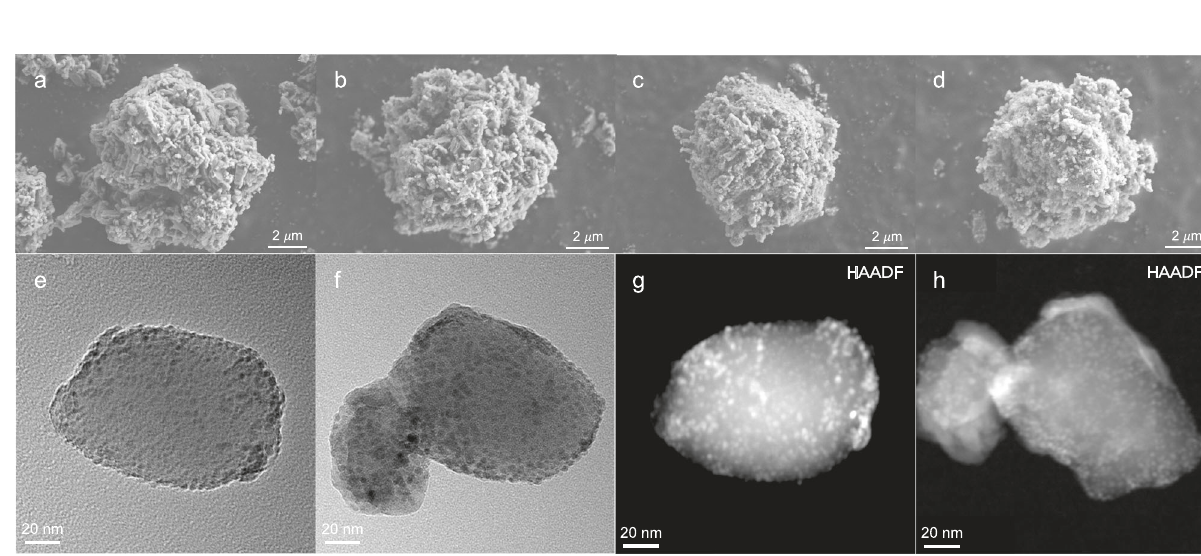
ZSM-5_H. TEM bright- fi eld images (scale bar=20nm) of e Co/ZSM-5_H and f Ni/ ZSM-5_H. HAADF images (scale bar=20nm) of g Co/ZSM-5_H and h